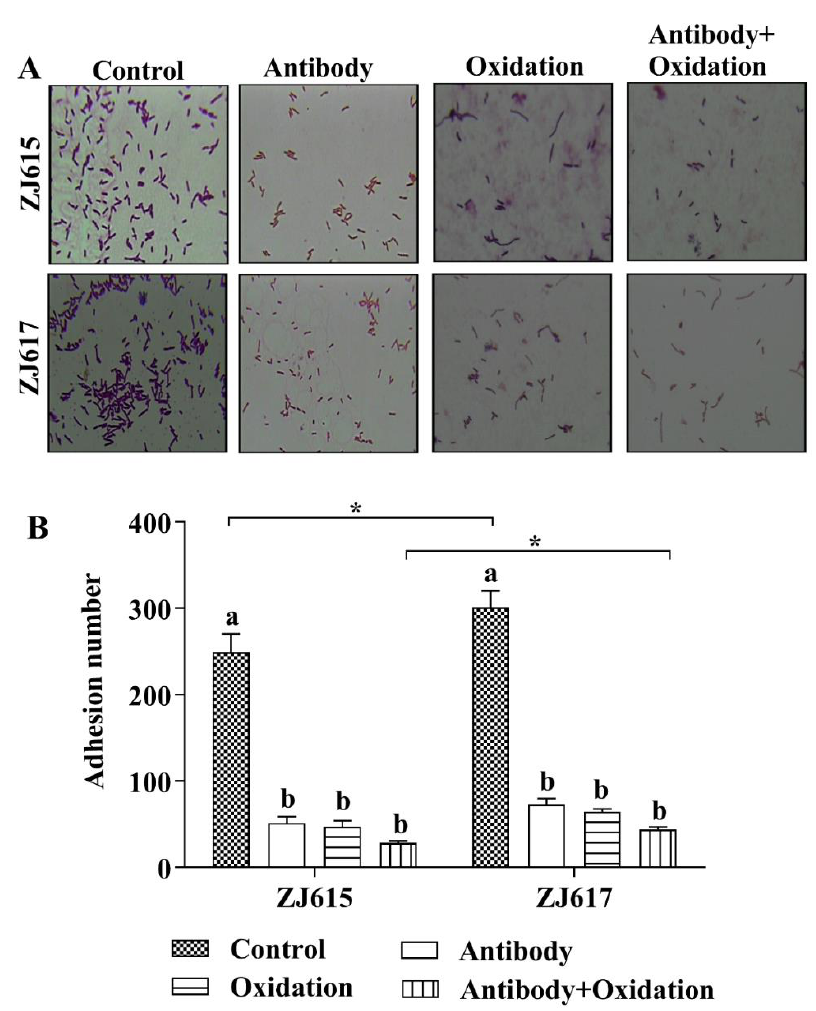
Figure 4. Adhesion of L. reuteri ZJ617 and ZJ615 to mucin. ( A ) Microscopy images of lactobacilli adhering to mucin-covered glass slides. Antibody bacteria were incubated with an anti-GAPDH antibody to block GAPDH activity. Oxidation, mucin was oxidized with periodate. ( B ) Quantification of the microscopy images ( n = 5). Eight fields of vision were randomly selected under an oil microscope to calculate the number of bacteria adhered to the surface. Magnification = 1000×. A one-way ANOVA with Duncan’s multiple range test was used. Different letters indicate significant differences within each strain ( p < 0.05). Asterisks indicate significant differences between the two strains ( p < 0.05).